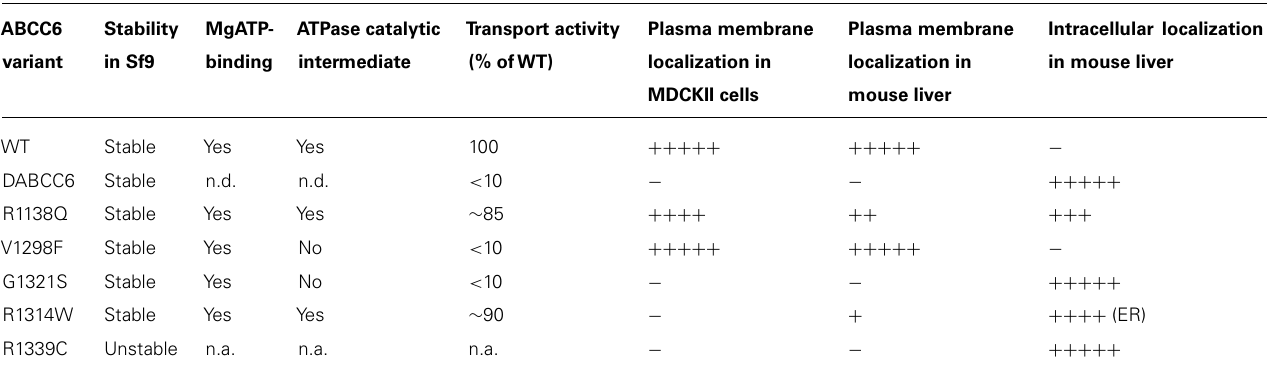
Table 1 | Function and intracellular localization ofABCC6